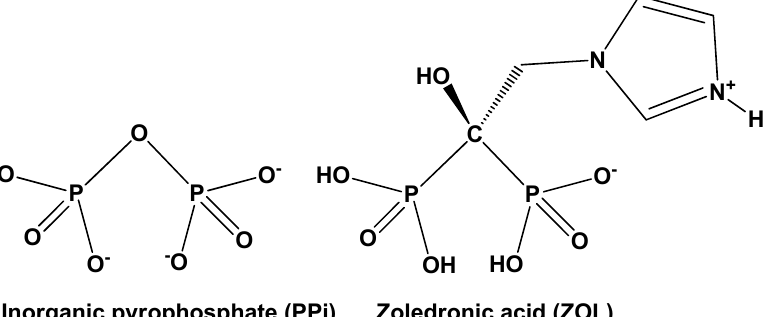
Figure 1. Schematic structures of inorganic pyrophosphate (PPi, left, in its fully deprotonated form) and zoledronic acid (right, in its zwitterionic form).